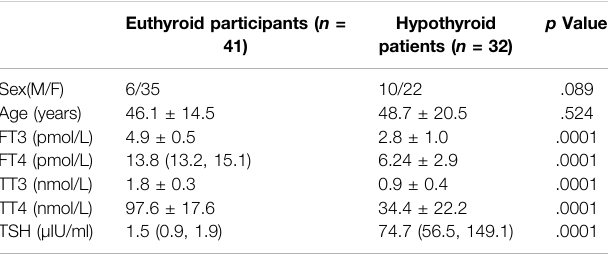
TABLE 2 | Demographic and clinical characteristics of the euthyroid and hypothyroid